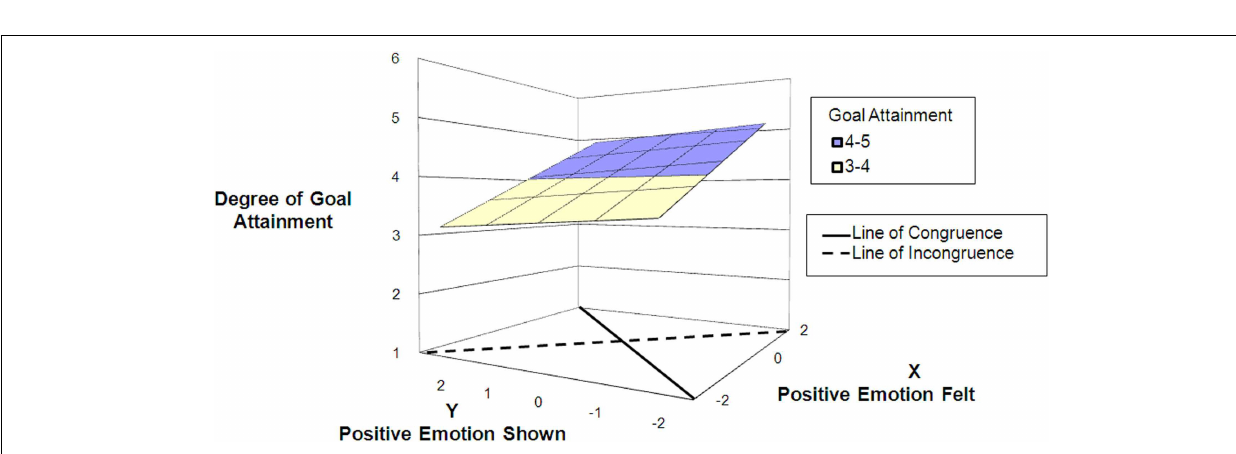
FIGURE 4 | Predicting goal attainment by positive emotions felt and shown during interactions with coworkers